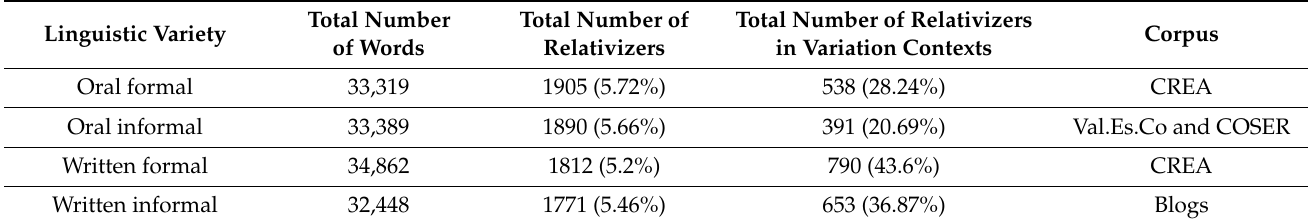
Table 1. Corpus study data by linguistic level. Relative frequency appears in parenthesis. For the total number of relativizers, the relative frequency was calculated over total number of words; for the total number of relativizers in variation contexts, the relative frequency was calculated over the total number of